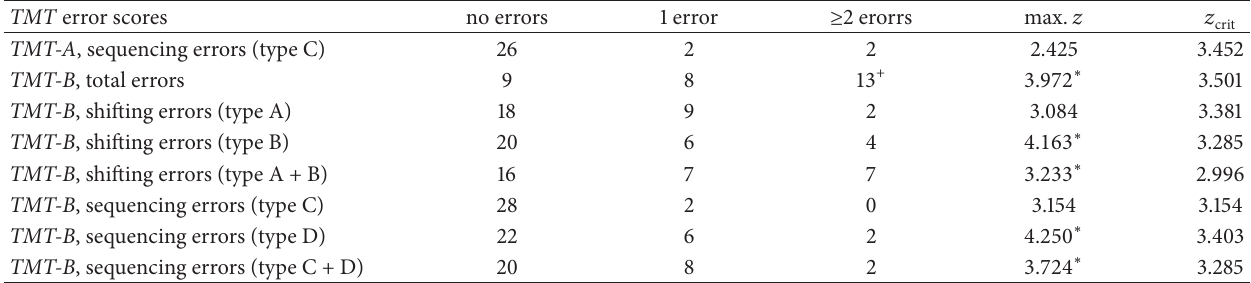
) over various TMT error scores. crit